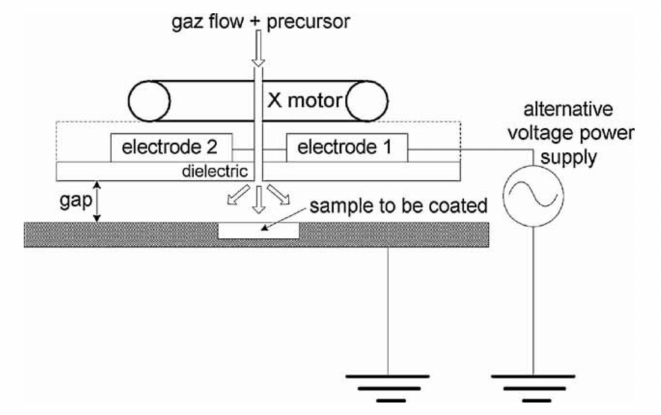
Figure 8. Scheme of the experimental atmospheric DBD plasma deposition reactor for the deposition